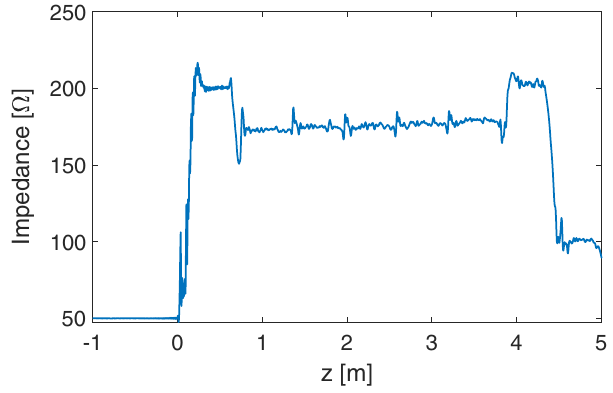
FIG. 11. The characteristic impedance with distance along the coaxial transmission line measured with